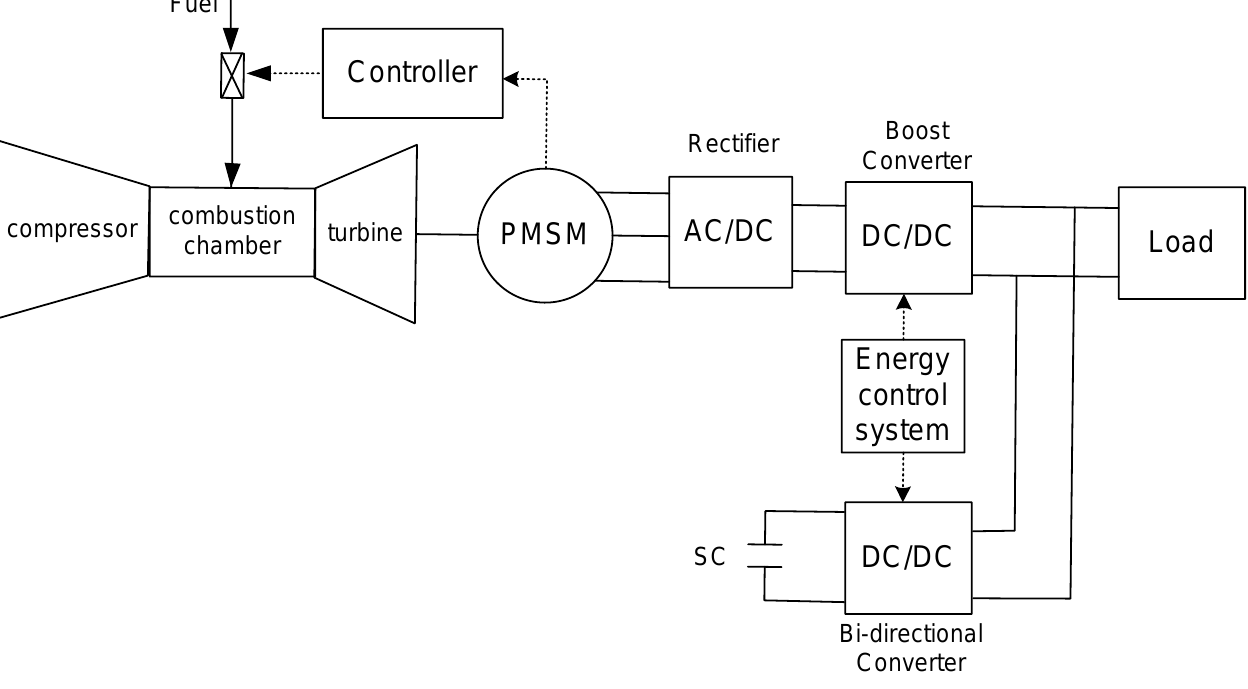
Figure 2. Block diagram of control system of the micro gas turbine. The Simulink model of the MGT used for modelling the charging station is shown in Figure 3. Due to their wide use in the energy industry, numerous MGT models have been developed and implemented in different software environments, such as [20,22 – 25]. Usu- ally, these models take into account only some specific processes in the turbine or are more complex, thus not allowing the achievement of large simulation times (hundreds and thousands of seconds) using standard computer architectures, such as those available in universities and research centers. From a literature review, it was found that Rowen ’ s